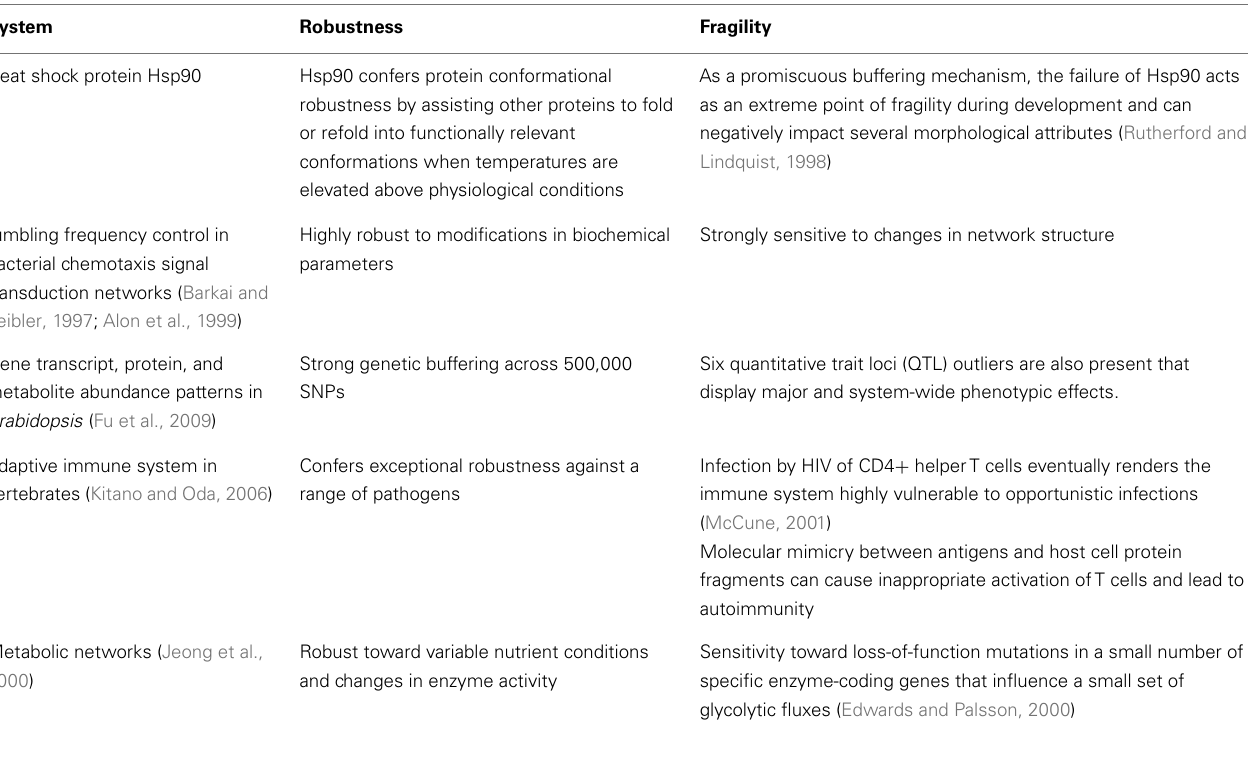
Table 2 | Robust-yet-fragile properties at different levels of biological